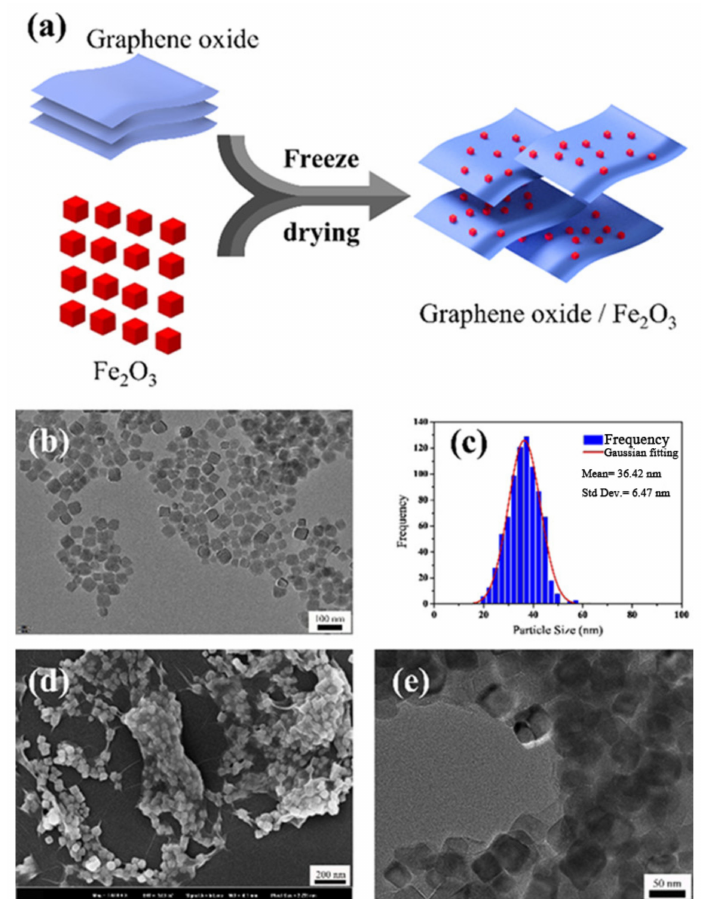
Figure 18. ( a ) Schematic diagram of the preparation and structure of the GO /Fe 2 O 3 hybrid. ( b ) HRTEM image of the Fe 2 O 3 nanoparticles, ( c ) size distribution of Fe 2 O 3 nanoparticles. ( d ) SEM image of sample 1, ( e ) HRTEM image of sample 1. ( a – c ) Reproduced with the permission of ref. [99]. Copyright 2021, Langmuir.